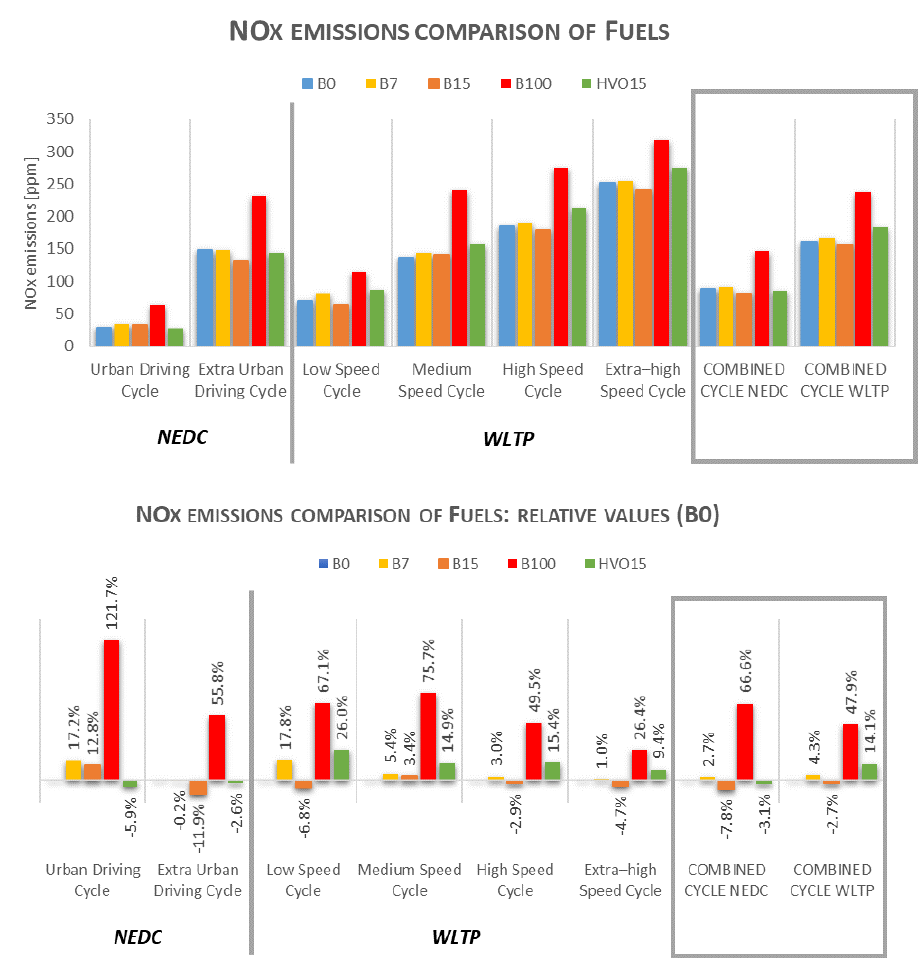
Figure 5. NOx emissions comparison of fuels, in total value and in percentage differences, in relation to the B0 fuel.